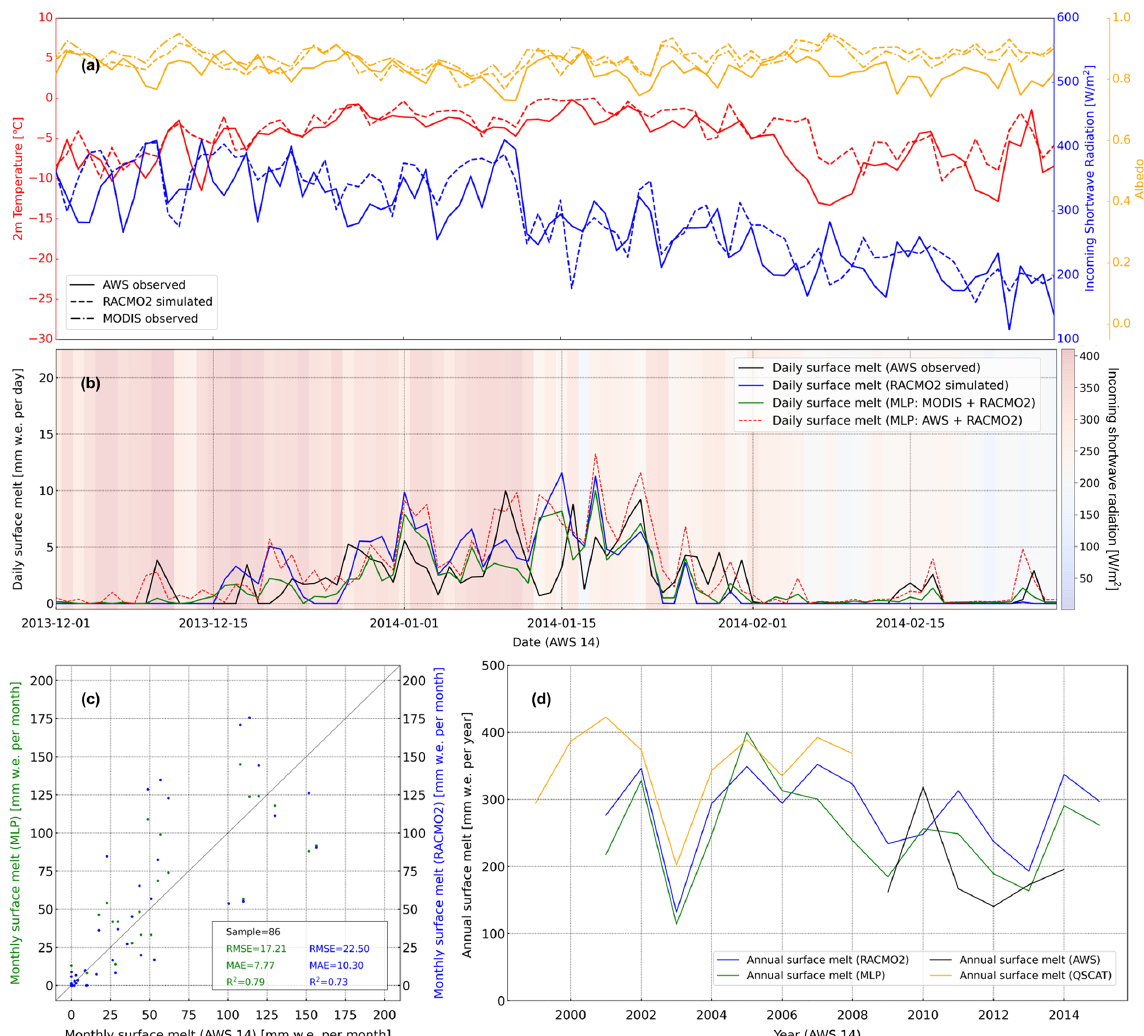
Figure 9. Automatic weather station (AWS) observations, regional atmospheric climate model version 2.3p2 (RACMO2) simulations, and results of the deep multilayer perceptron (MLP) model applied to RACMO2 and Moderate Resolution Imaging Spectroradiometer (MODIS) data at AWS 14: (a) discrepancies in input meteorological parameters among the AWS observations, RACMO2 simulations, and MODIS observations; (b) daily surface melt time series from the original RACMO2 simulations, AWS observations, and MLP estimations using a different input data set for albedo (from either MODIS or AWS observations) and the other meteorological parameters from RACMO2 during the austral summer 2013–2014; (c) a scatterplot of monthly surface melt from the deep MLP model estimations and the original RACMO2 simulations compared to AWS observations; and (d) annual melt fluxes (July–June) at AWS 14 from AWS observations, RACMO2 simulations, the deep MLP predictions, and QuikSCAT (Quick Scatterometer) estimations (Trusel et al.,